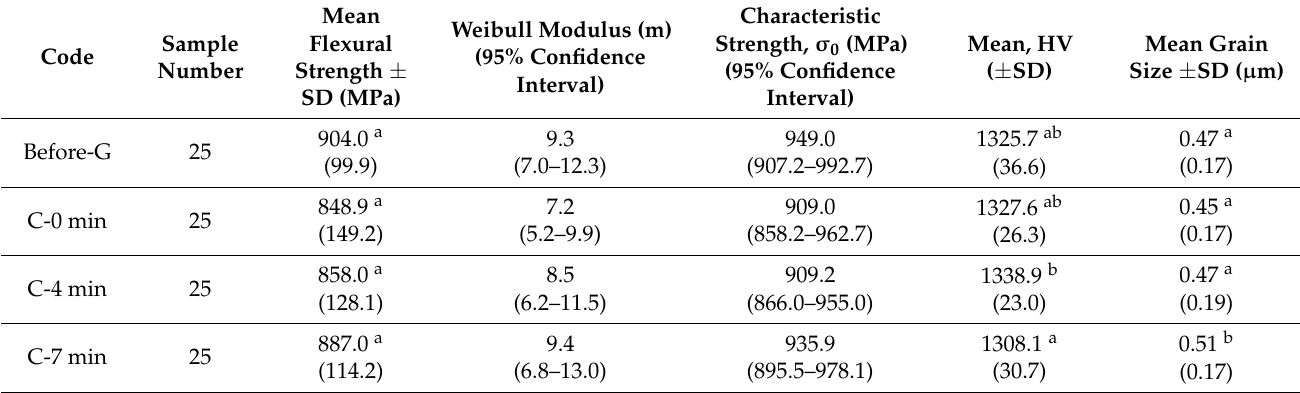
Table 3. Flexural strength, Weibull modulus, characteristic strength, hardness, and mean grain size in each